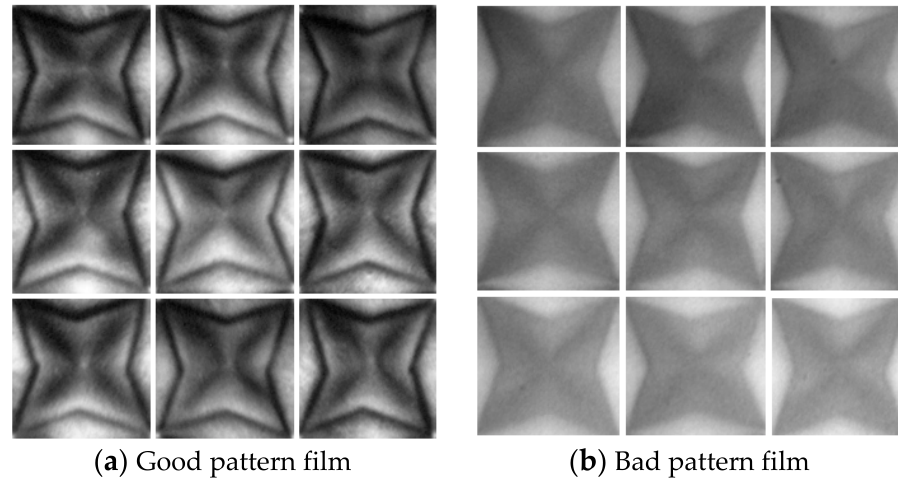
Figure 6. Separated good and bad 3D film images.